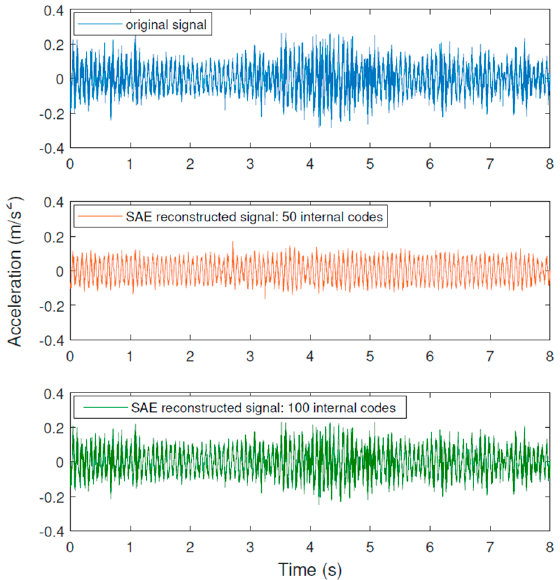
Figure 12. An original response of the Várzea Nova viaduct and its respective signals reconstructed by SAE. Table 6. V á rzea Nova viaduct: correct classification rates in